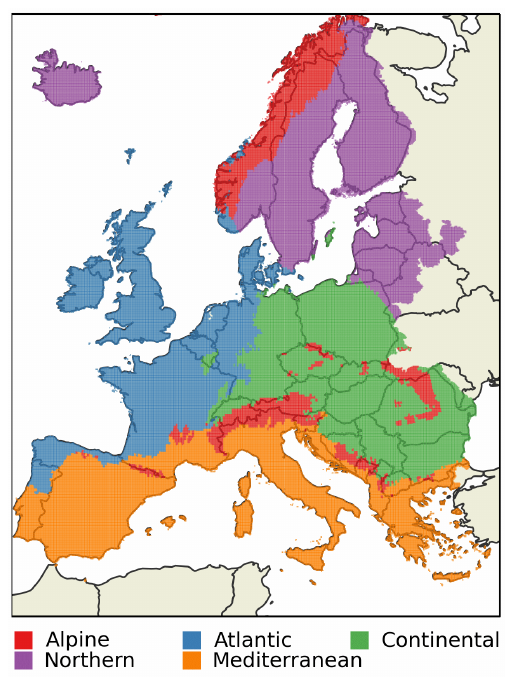
Figure 2. European macro-regions used in the IPCC AR5 (Kovats et al., 2014) based on an environmental stratification after Metzger et al. (2005). Graphics created by the authors, based on GIS data provided by Marc J. Metzger, University of Edinburgh. The data are remapped to the 5km grid used in this